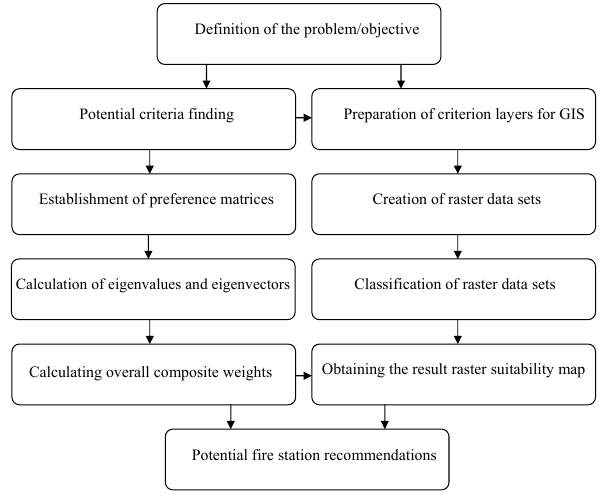
Figure 2. The conceptional flow chart of the methodology Fig. 2. The conceptional flow chart of the